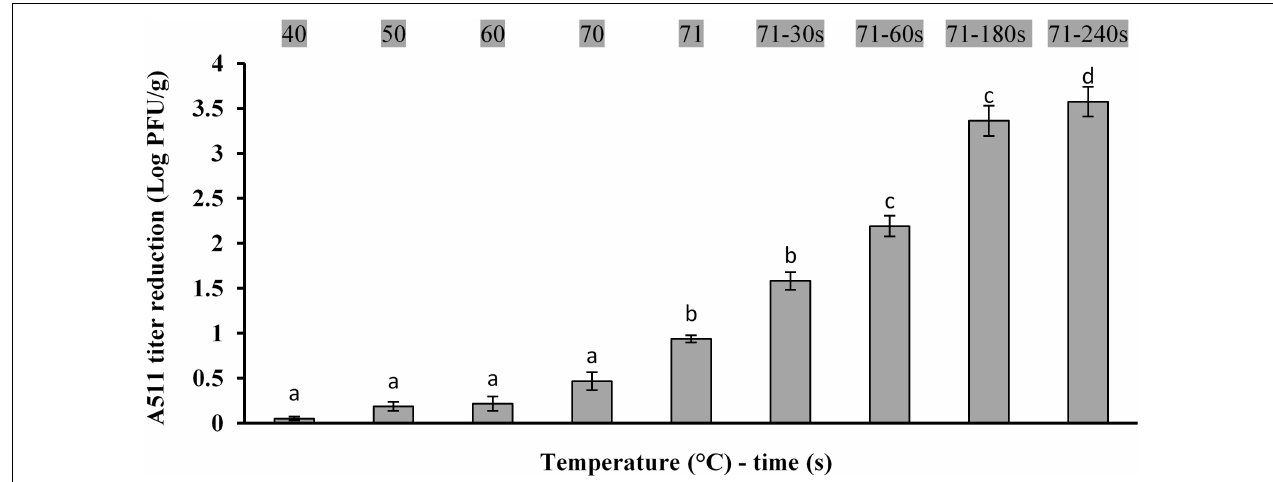
FIGURE 3 | Changes in bacteriophage A511 titers following heating at 40, 50, 60, 70, 71 ◦ C and holding for 30, 60, 180, 240 s at 71 ◦ C. Different letters above bars indicate statistical significance between two means at the same temperature–time ( P < 0.05).